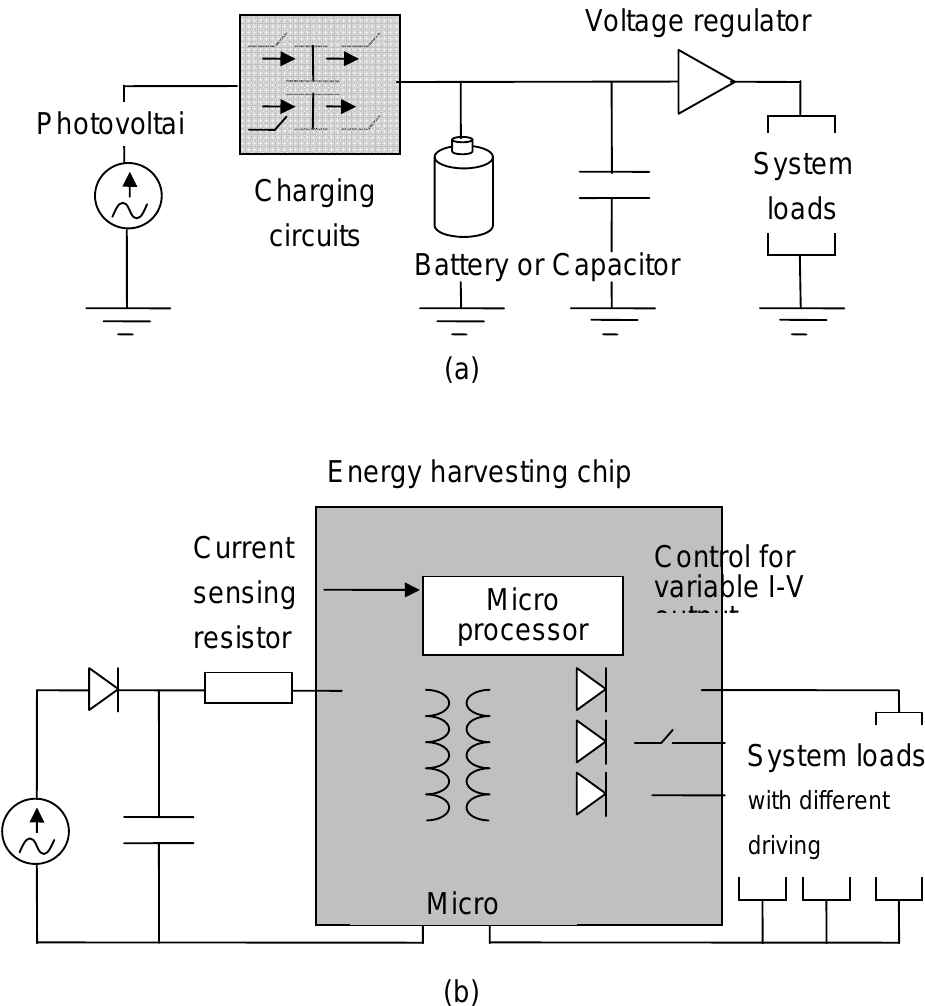
Figure 1. Electrical diagrams of (a) a traditional solar cell charging circuits, and (b) the novel power supply with the energy harvesting